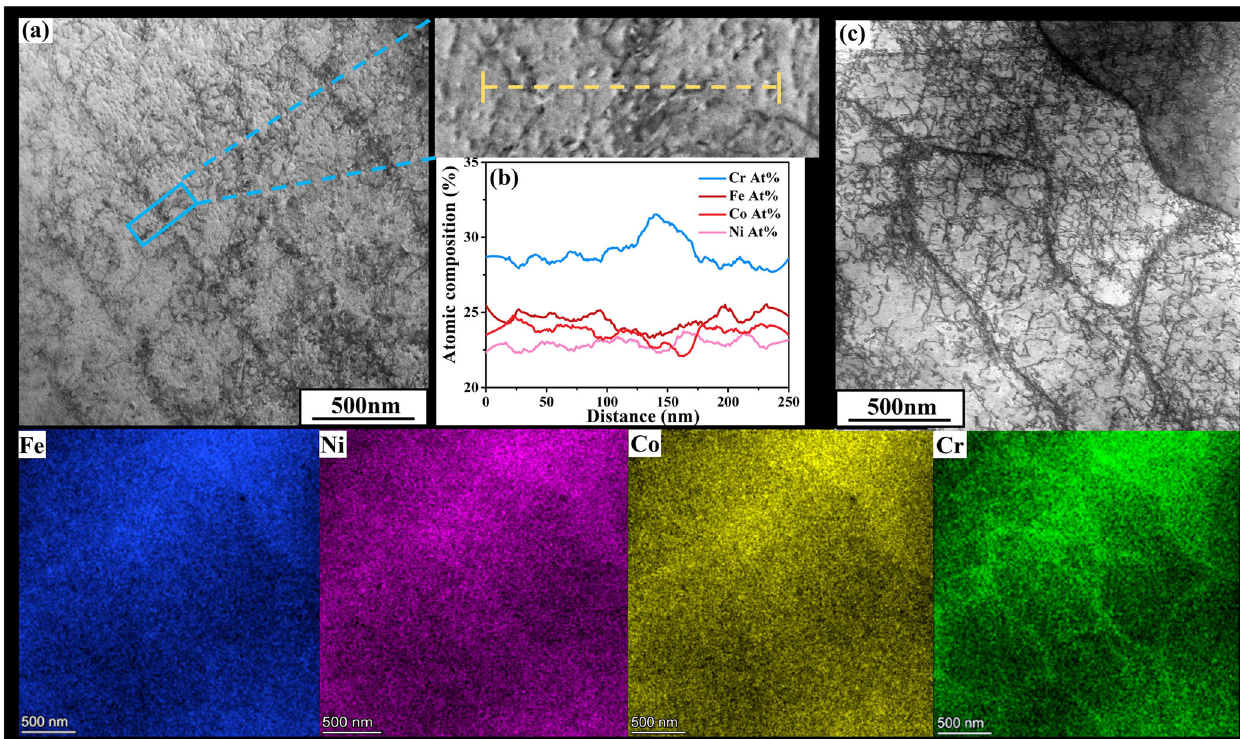
Fig. 4 Characterization of microstructures and composition distribution in CoCrFeNiN 0.07 . a Bright fi eld (BF) STEM images of the dislocation cell structure from edge-on orientation with b EDS-line scan results, and c dislocation cell structure from end-on orientation with EDS elemental